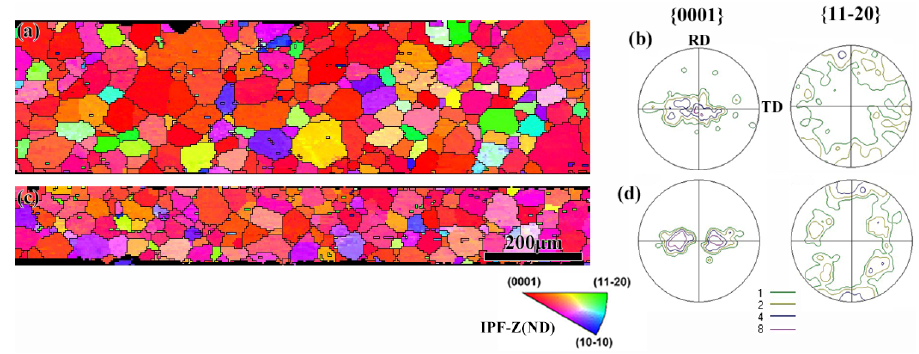
Figure 4. Orientation maps and pole figures of 80% and 90% cold ‐ rolled samples following recrystallization annealing at 800 °C for 15 min, ( a , b ) 80% reduction; ( c , d ) 90% reduction.